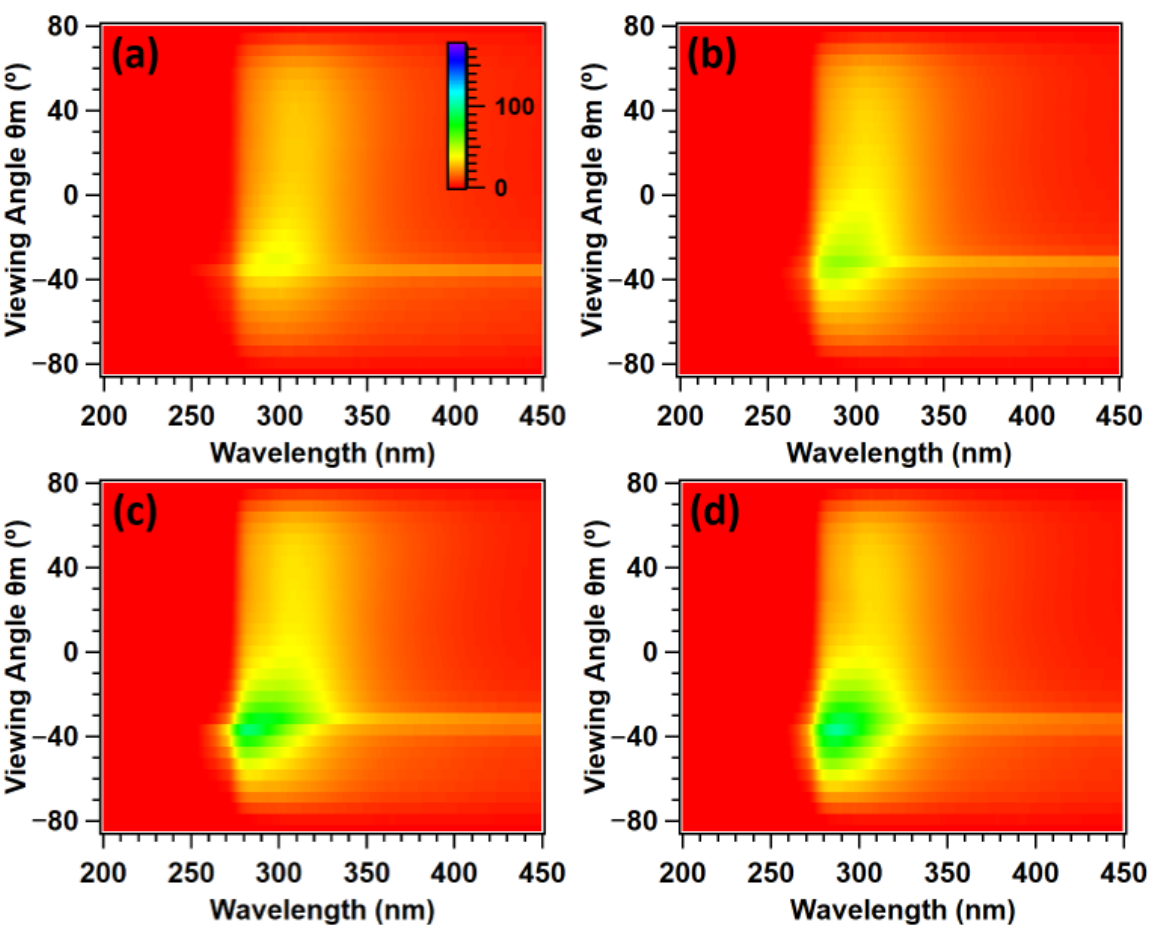
Figure 4. Scattering cones of ( a ) 0; ( b ) 10; ( c ) 20; ( d ) 40 BIOS passes. Specular reflection and obscuration artifacts were removed, and the viewing angle is in the plane of illumination ( ϕ m = 0°). The z -axis corresponds to the reflectance (%), with scale inset ( a ).